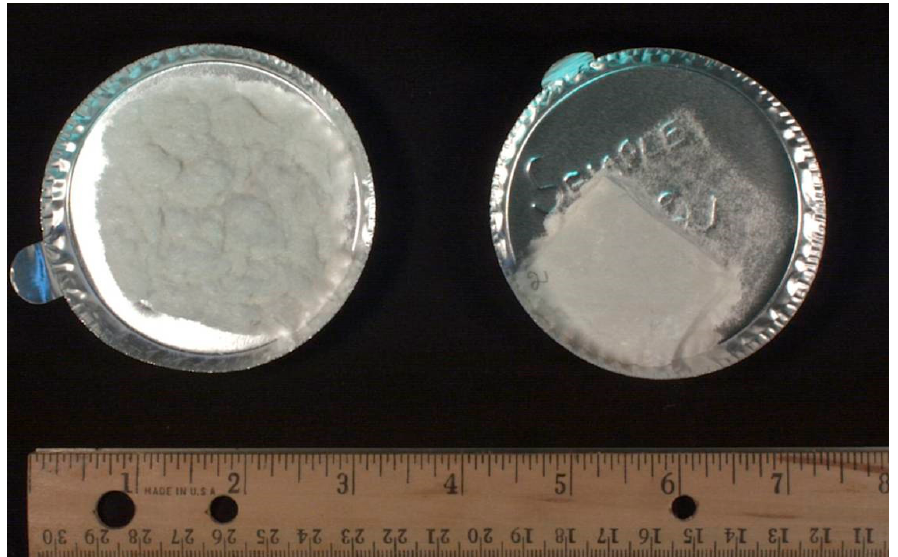
Figure 21. Fibers in consolidated regrind panel have average length of 5 mm.